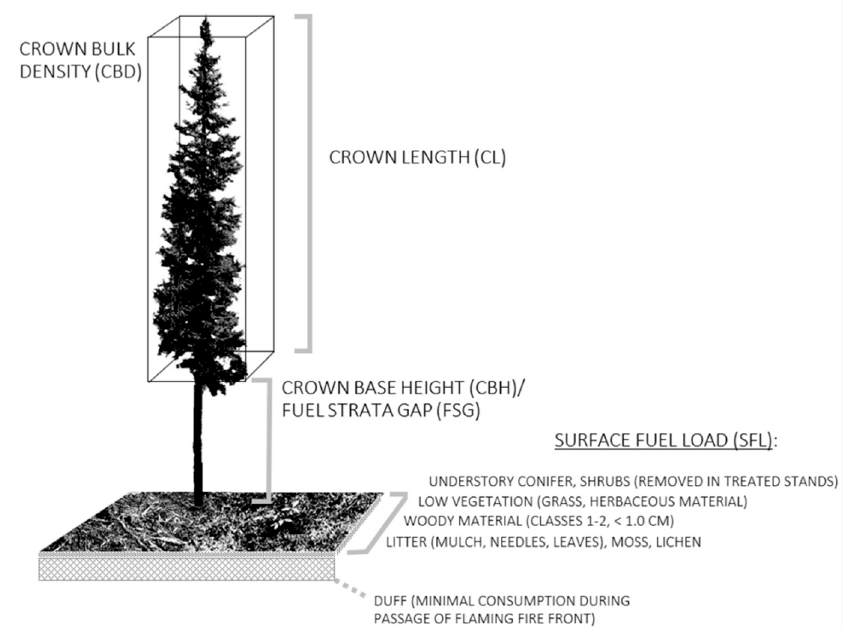
Figure 3. Diagram of fuel metrics required for determining inputs to crown fire modelling frameworks. Tree-level metrics are shown (denoted by the crown qualifier). When reported at the stand level, canopy is used (e.g., canopy bulk density).